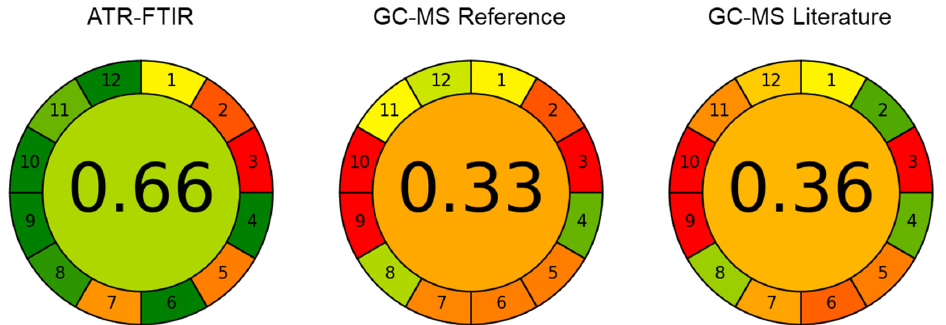
Figure 4. Results of evaluation according to the Analytical GREEnness metric approach for ATR- spectroscopy with solvent-free lipid separation, the applied GC-MS reference method, and a GC-MS method from the literature [15]. The green-yellow-red (i.e., best to worst) colour range represents the performance of each principle.